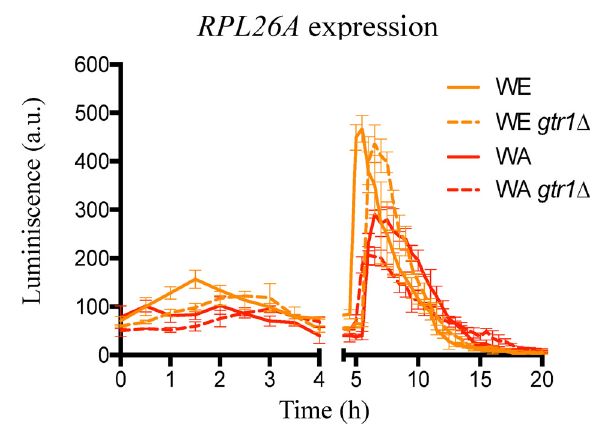
FIGURE 2 | Indirect TORC1 activity in GTR1 null mutants. Indirect monitoring of TORC1 activity was evaluated as luciferase expression controlled by RPL26A promoter under micro-culture conditions in SM300 medium until 20 h. Plotted values correspond to the average of three biological replicates, with their standard error represented by bars (mean ± SE). WE: Wine/European; WA: West